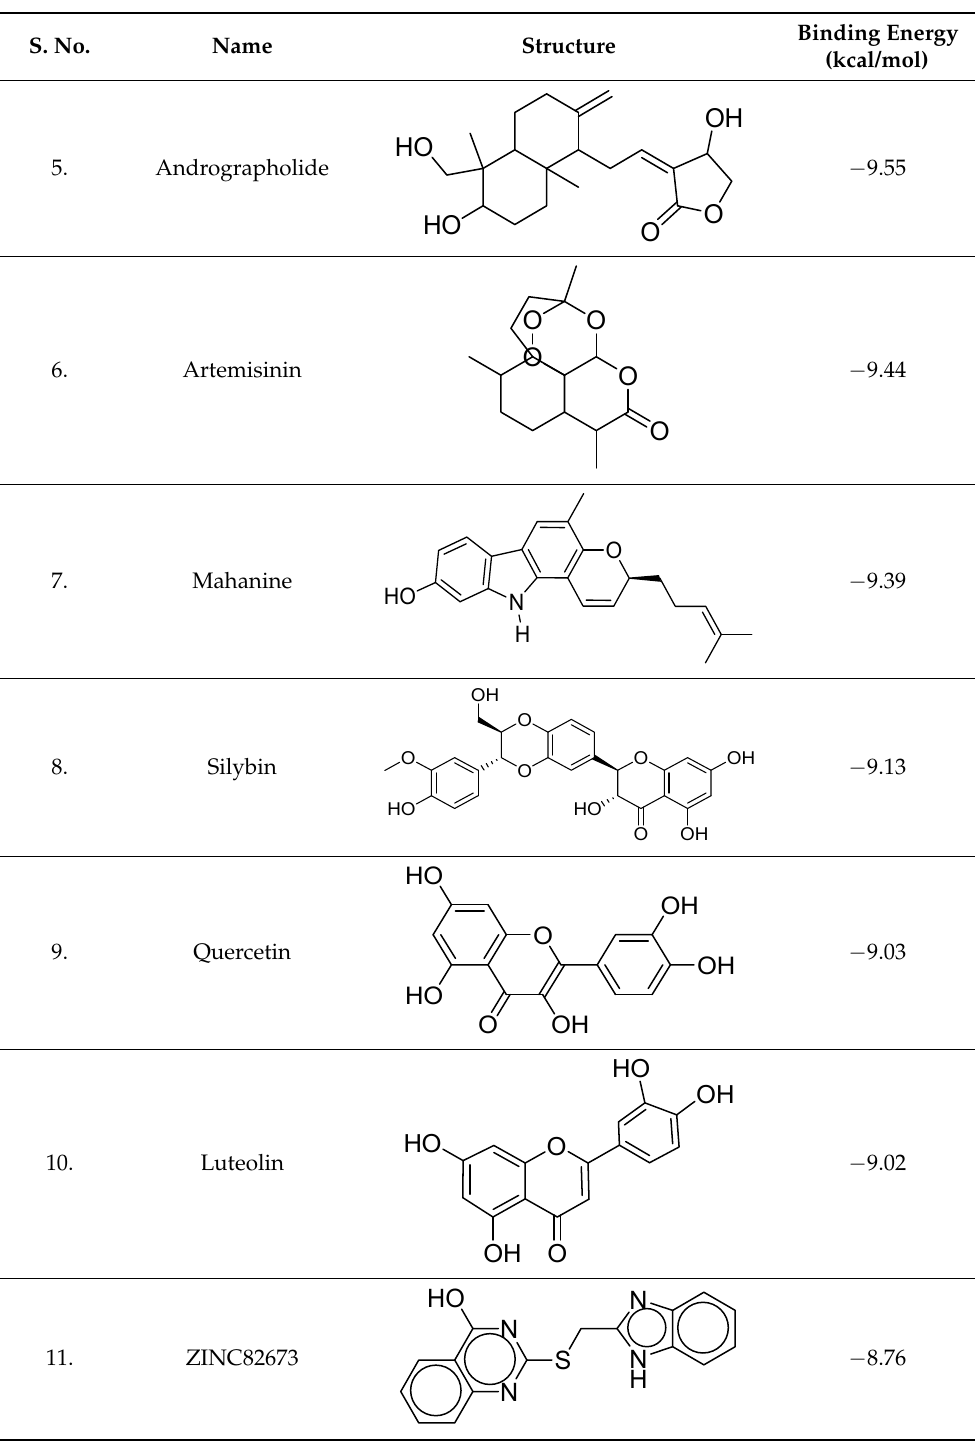
Figure 3. Comparative binding pose of the docked ligand guggulsterone (green) to the native pose of the reference crystallized ligand ADP ribose (red) within the active binding site of the viral ARP enzyme. 3.5. Molecular Dynamic Simulation Guggulsterone was proposed as a potential antagonist of the viral ARP enzyme of SARS-CoV-2 using dynamic simulation (timeframe of 100 ns) with the help of Desmond tool in Schrodinger software. Based on the atomic selection, the RMSD values for the mac- romolecular residues were calculated by realigning all macromolecular frames over the stationary reference frame of the backbone in MD simulations. RMSD analysis confirmed the effective operation of the equilibrated simulation process based on structural valida- tion through the procedure. The ligand RMSD indicated the ligand’s stability concerning the macromolecular binding residues throughout the simulation by aligning the heavy